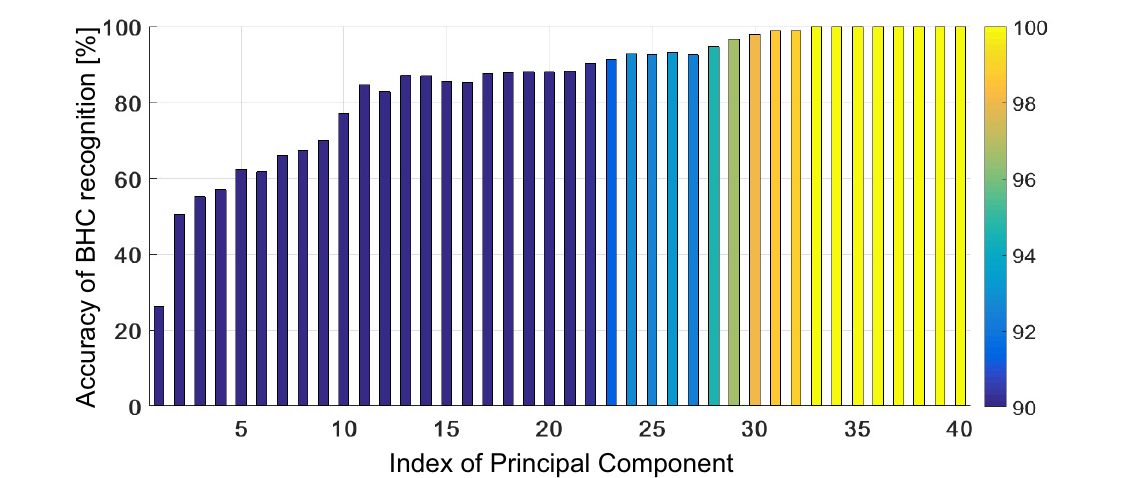
Figure 7. Accuracy of BHC recognition (average) obtained with adaptive KSVM versus the number of PCs. The test was performed using 2-fold CV and 30 initialization points for the NM algorithm.